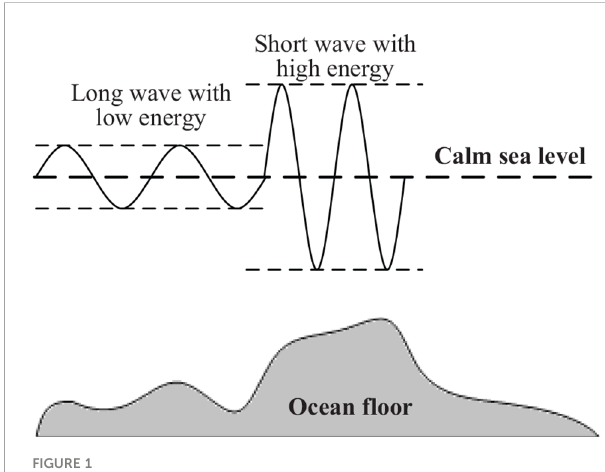
FIGURE 1 Illustration of wave heights and lengths in shallow